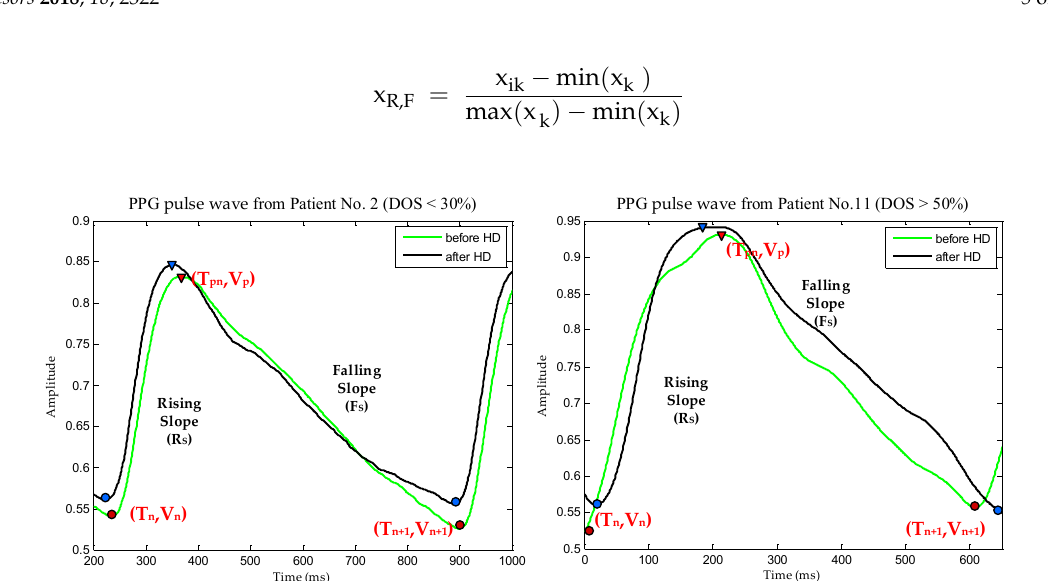
Figure 3. PPG pulse wave for RS and FS calculation before and after HD treatment in two patients.